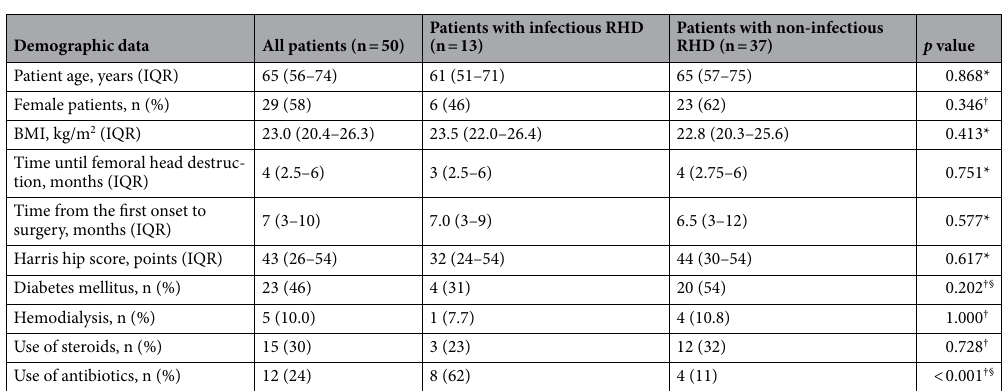
Table 1. Patient demographic data. BMI Body mass index, IQR Interquartile range, RHD Rapid hip destruction. *Mann–Whitney’s U test. † Fisher’s exact test. § Statistically significant.